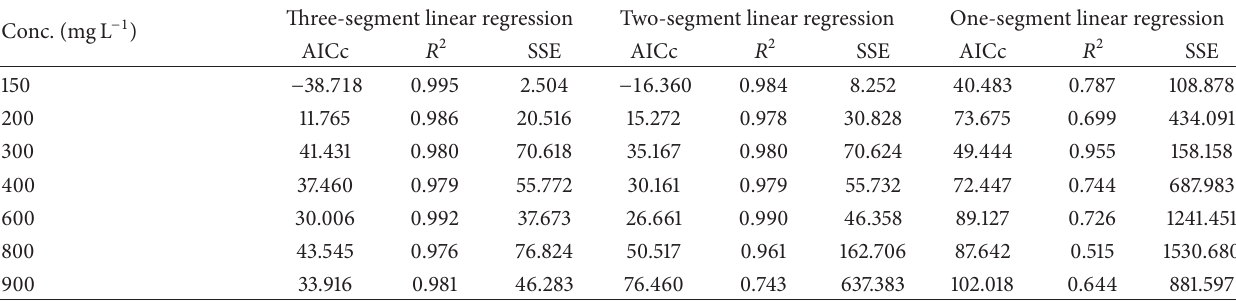
Table 4: Comparison of models by AICs.